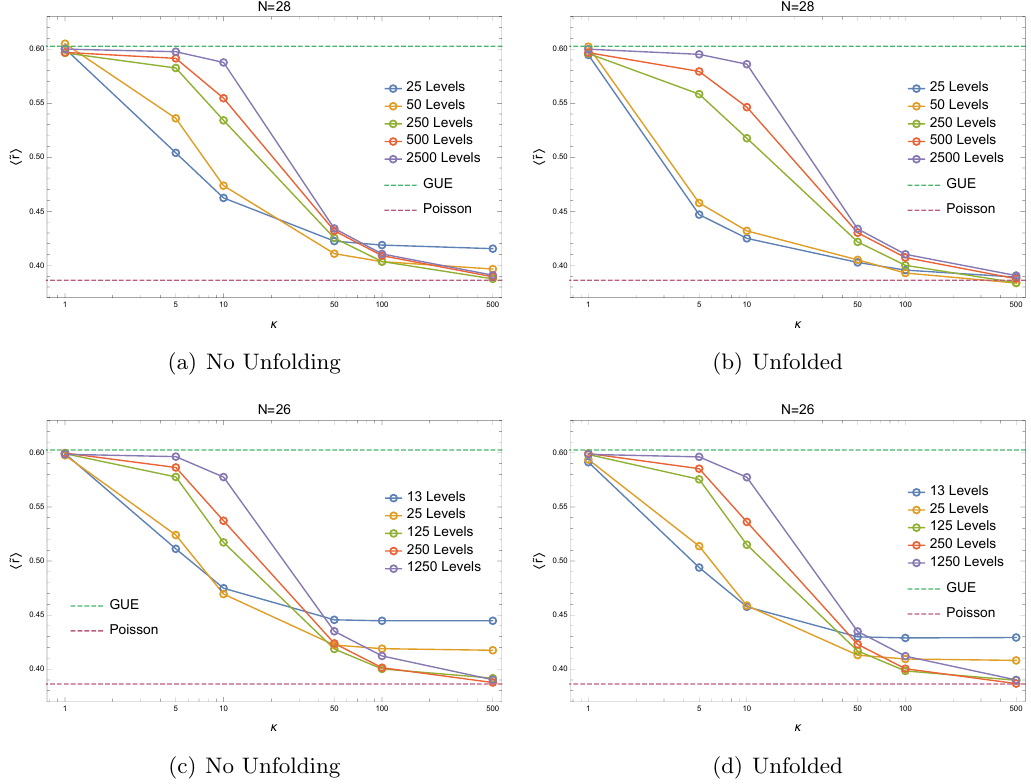
Figure 24 . The mean value of the ~ r -parameter of (a) N = 28 spectrum without unfolding, (b) N = 28 unfolded spectrum, (c) N = 26 spectrum without unfolding and (d) N = 26 unfolded spectrum (1 5 (cid:20) 5 500). The average is performed over M = 100 ensembles, respectively. The ~ r -parameter are computed subsectors of the spectra including M levels starting from the ground state ( M = 50 ; 100 ; 500 ; 1000).